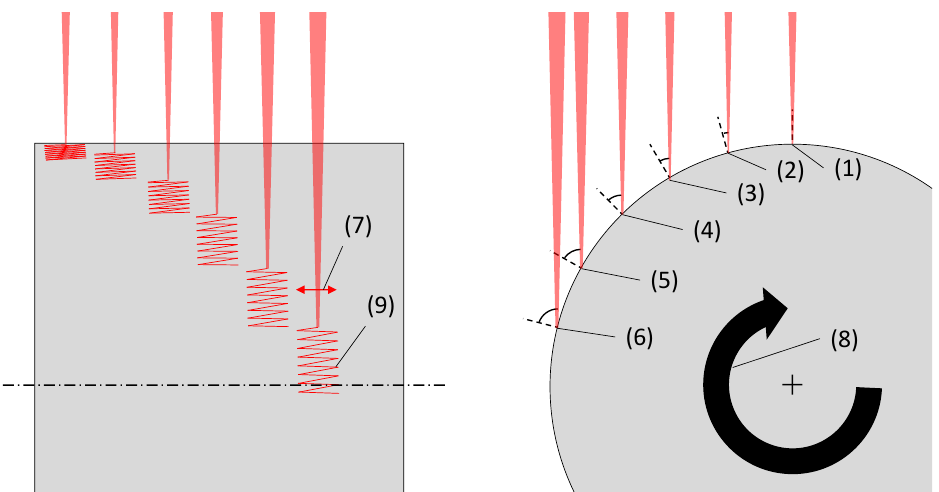
Figure 2. Front view ( left ) and side view ( right ) of the calibration experiment at the different beam incidence configurations from 0° (1) to 75°(6) in 15° intervals. The laserbeam is deflected by a linescan